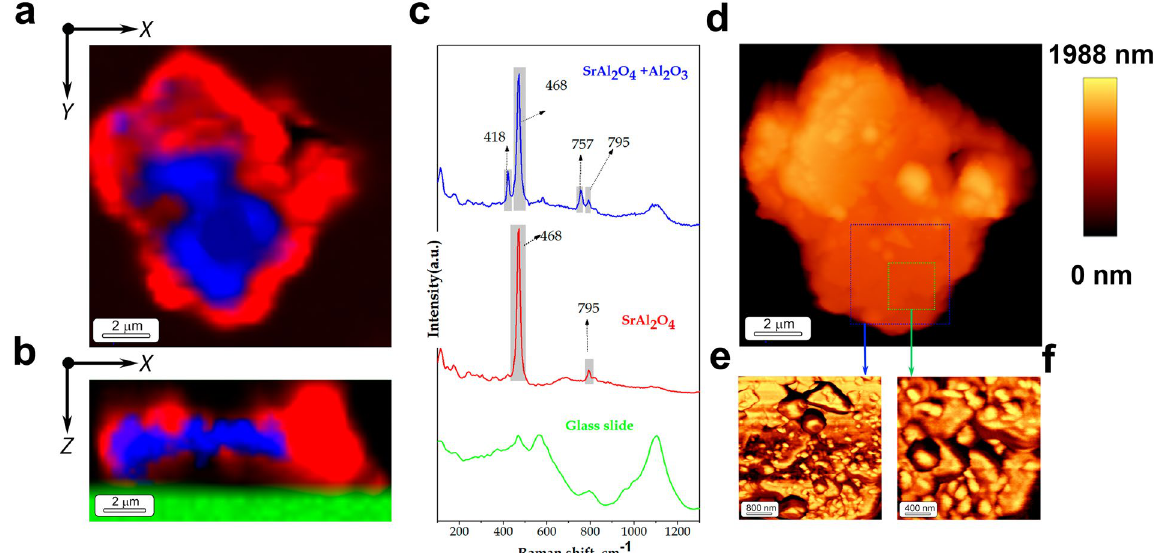
Figure 2. Corroborating core-shell structure by Coupling Confocal Raman and AFM technique. ( a ) XY and ( b ) XZ Raman image of the platelet based on SrAl 2 O 4 :Eu, Dy phosphor heated at 1000 °C for 2 h in 90N 2 -10H 2 atmosphere, employing a salt/SrAl 2 O 4 molar ratio of 3:1, as precursor an alumina platelets with an average particle size, d 50 ≈ 6 μ m and Al 2 O 3 /SrO molar ratio of 2. ( c ) Average Raman spectra correspond to each phase; the colour-coded Raman spectrum corresponds with the colour-coded areas in Raman images. ( d ) The AFM topography of the same scanning area in Raman study. ( e , f ) AFM phase imaging micrographs of the areas selected on Fig.